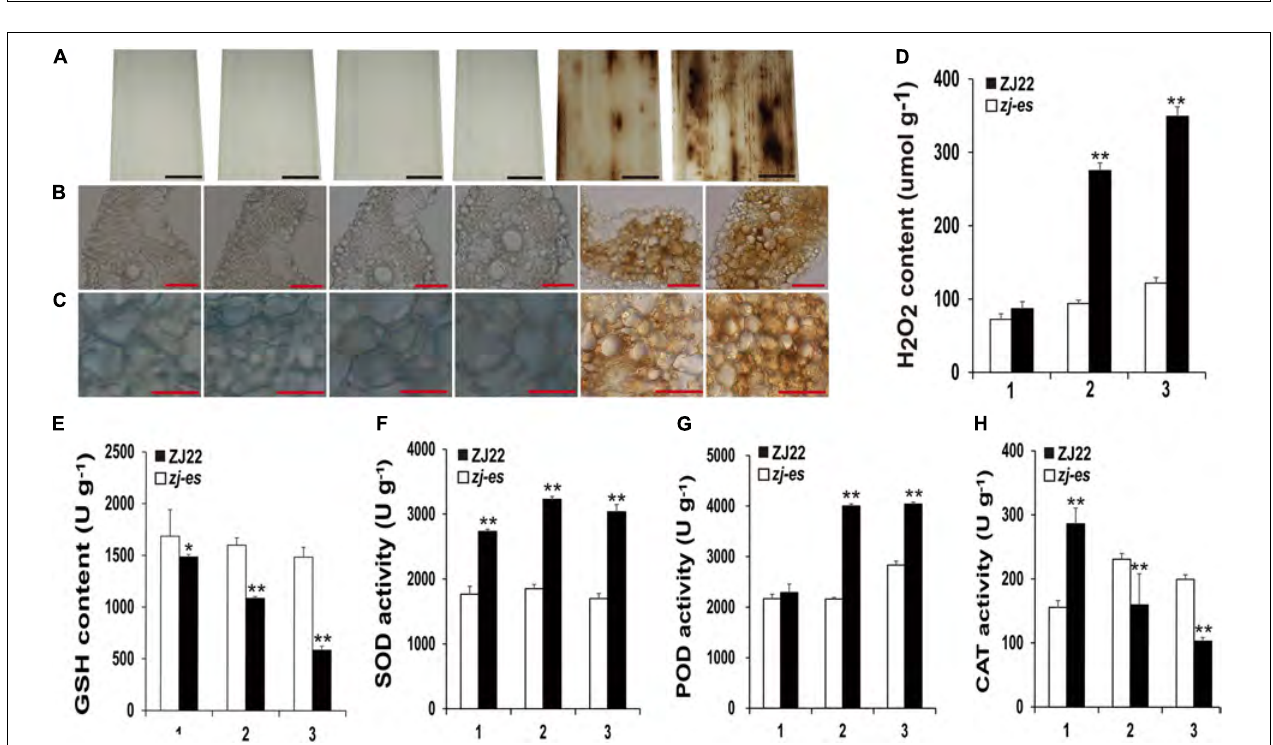
FIGURE 13 | Diaminobenzidine (DAB) staining and the determination of enzyme activities involved in scavenging and generating the mechanism of ROS. (A–C) DAB staining for ROS accumulation of ZJ22 and zj-es mutant leaves (From left to right, each image representing the flag, second and third leaves of ZJ22, and then the flag, second and third of zj-es ). (D) The content of hydrogen peroxide (H 2 O 2 ) in the wild-type ZJ22 and zj-es mutant at the six-leaf stage. (E–H) The enzyme activities of glutathione (GSH), superoxide dismutase (SOD), peroxidase (POD), and catalase (CAT) in the wild-type ZJ22 and zj-es mutant at the six-leaf stage. 1: flag leaves; 2: second leaves from top; 3: 3rd third leaves from top. *Significant difference at p < 0.05; **Significant difference at p <